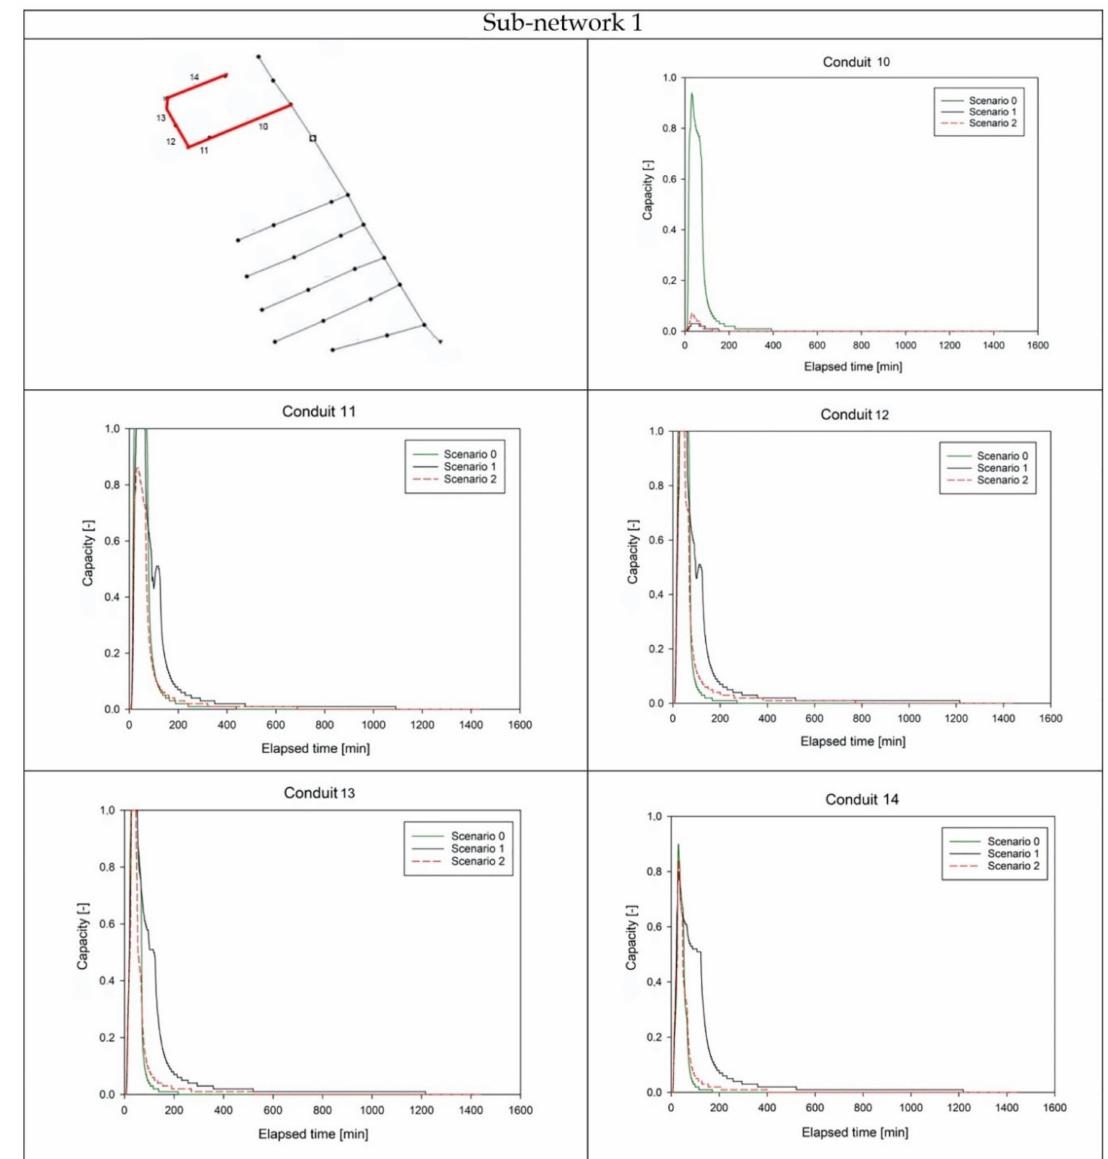
Figure A3. Conduits’ capacity in sub-network 1, highlighted in red in the first picture where the drainage network schematization is